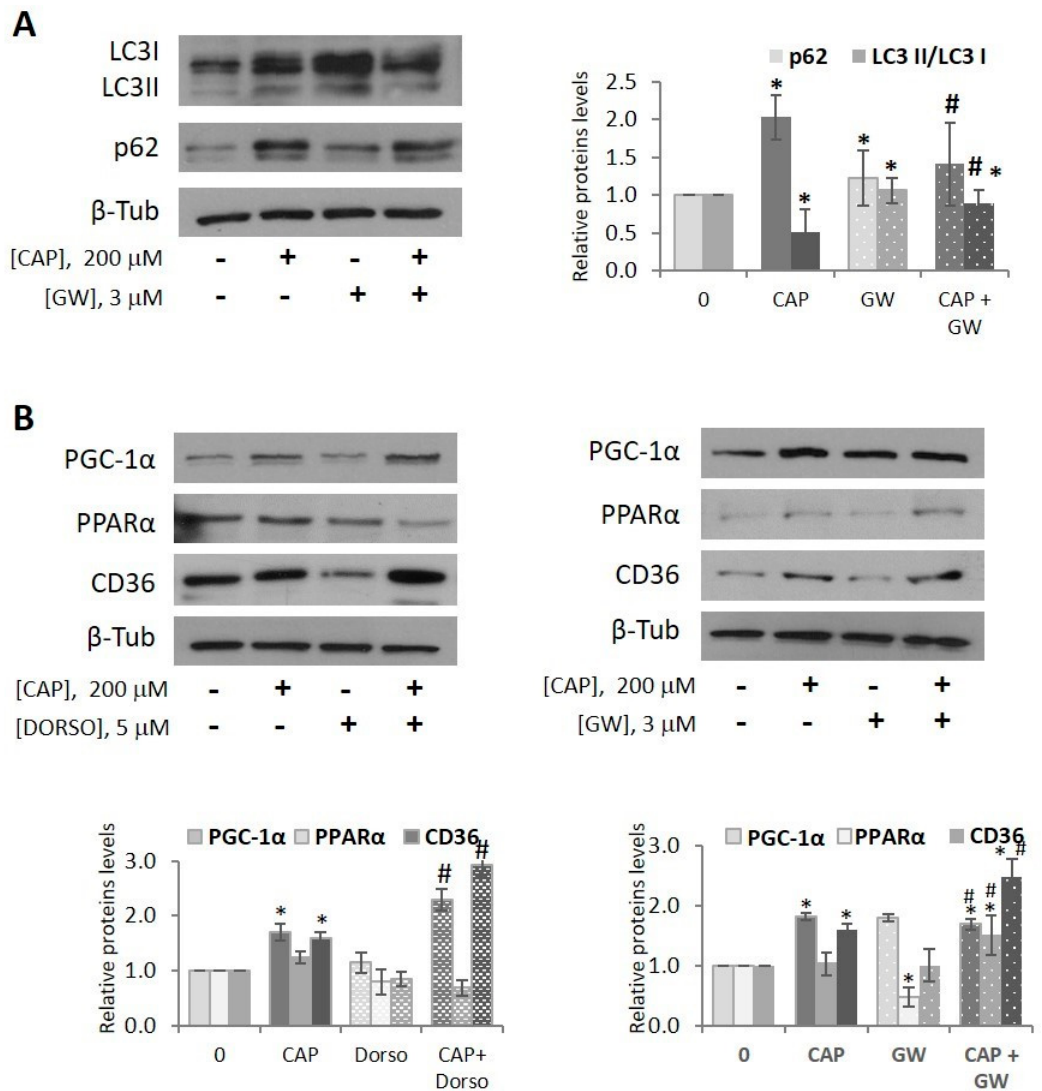
Figure 4. Capsaicin blocks autophagy and upregulates PGC-1 α in HepG2 cells. HepG2 cells were cultured in EMEM medium without serum for 24 h. ( A ) Cells were pretreated with vehicle or 3 µ M GW9662 (GW) for 30 min and treated with or without 200 µ M CAP for 8 h. Cells were lysed and levels of LC3 and p62 were determined by immunoblotting. β -tubulinserves as a loading control. The densitometric analysis of the bands is shown on the right of the blot. ( B ) Cells were pretreated with vehicle, 5 µ M dorsomorphin (DORSO) or 3 µ M GW9662 (GW) for 30 min and treated with or without 200 µ M capsaicin for 8 h. Cells were lysed and levels of PGC-1 α , PPAR α and CD36 proteins were determined by immunoblotting. β -tubulin serves as a loading control. The densitometric analysis of the bands is shown under the blots. Data are the mean ± SEM of three experiments. Statistical significance was determined by two-way ANOVA and Dunnett’s multiple comparisons test. Comparisons were vs untreated cells (* p < 0.05) or capsaicin-treated cells (# p < 0.05).